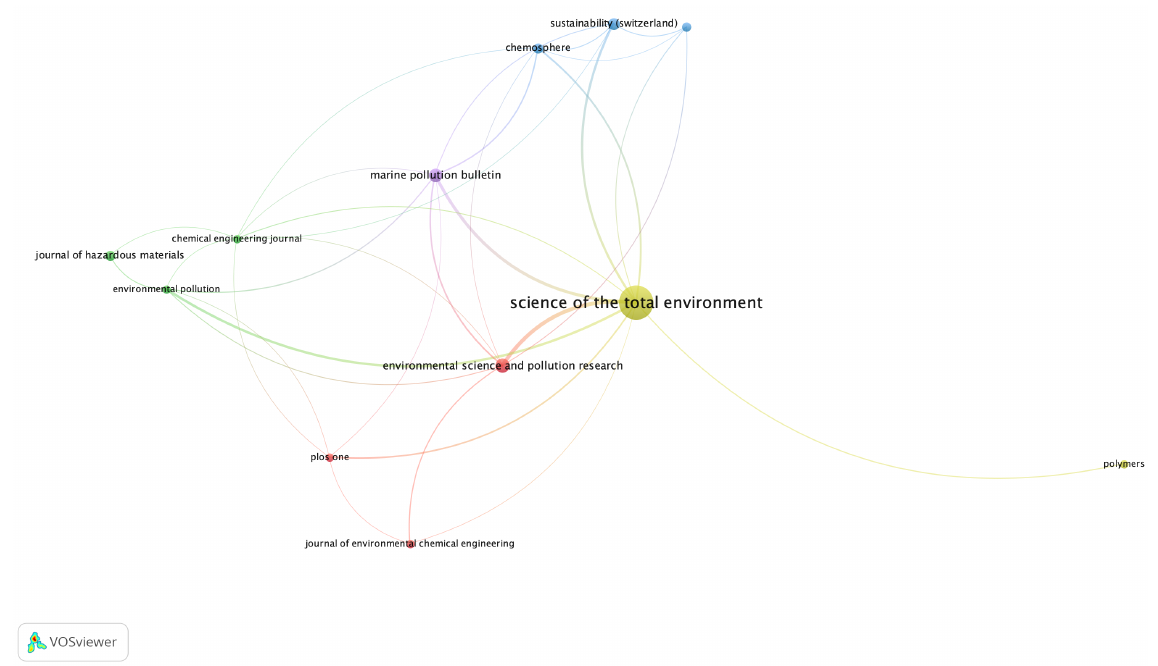
Figure 4. Network visualization of sources with more importance in the field, included in Table 1, in terms of the number of